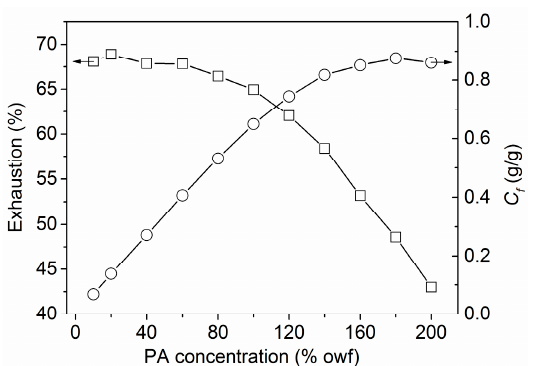
Figure 4. Influence of initial PA concentration on its uptake by wool.